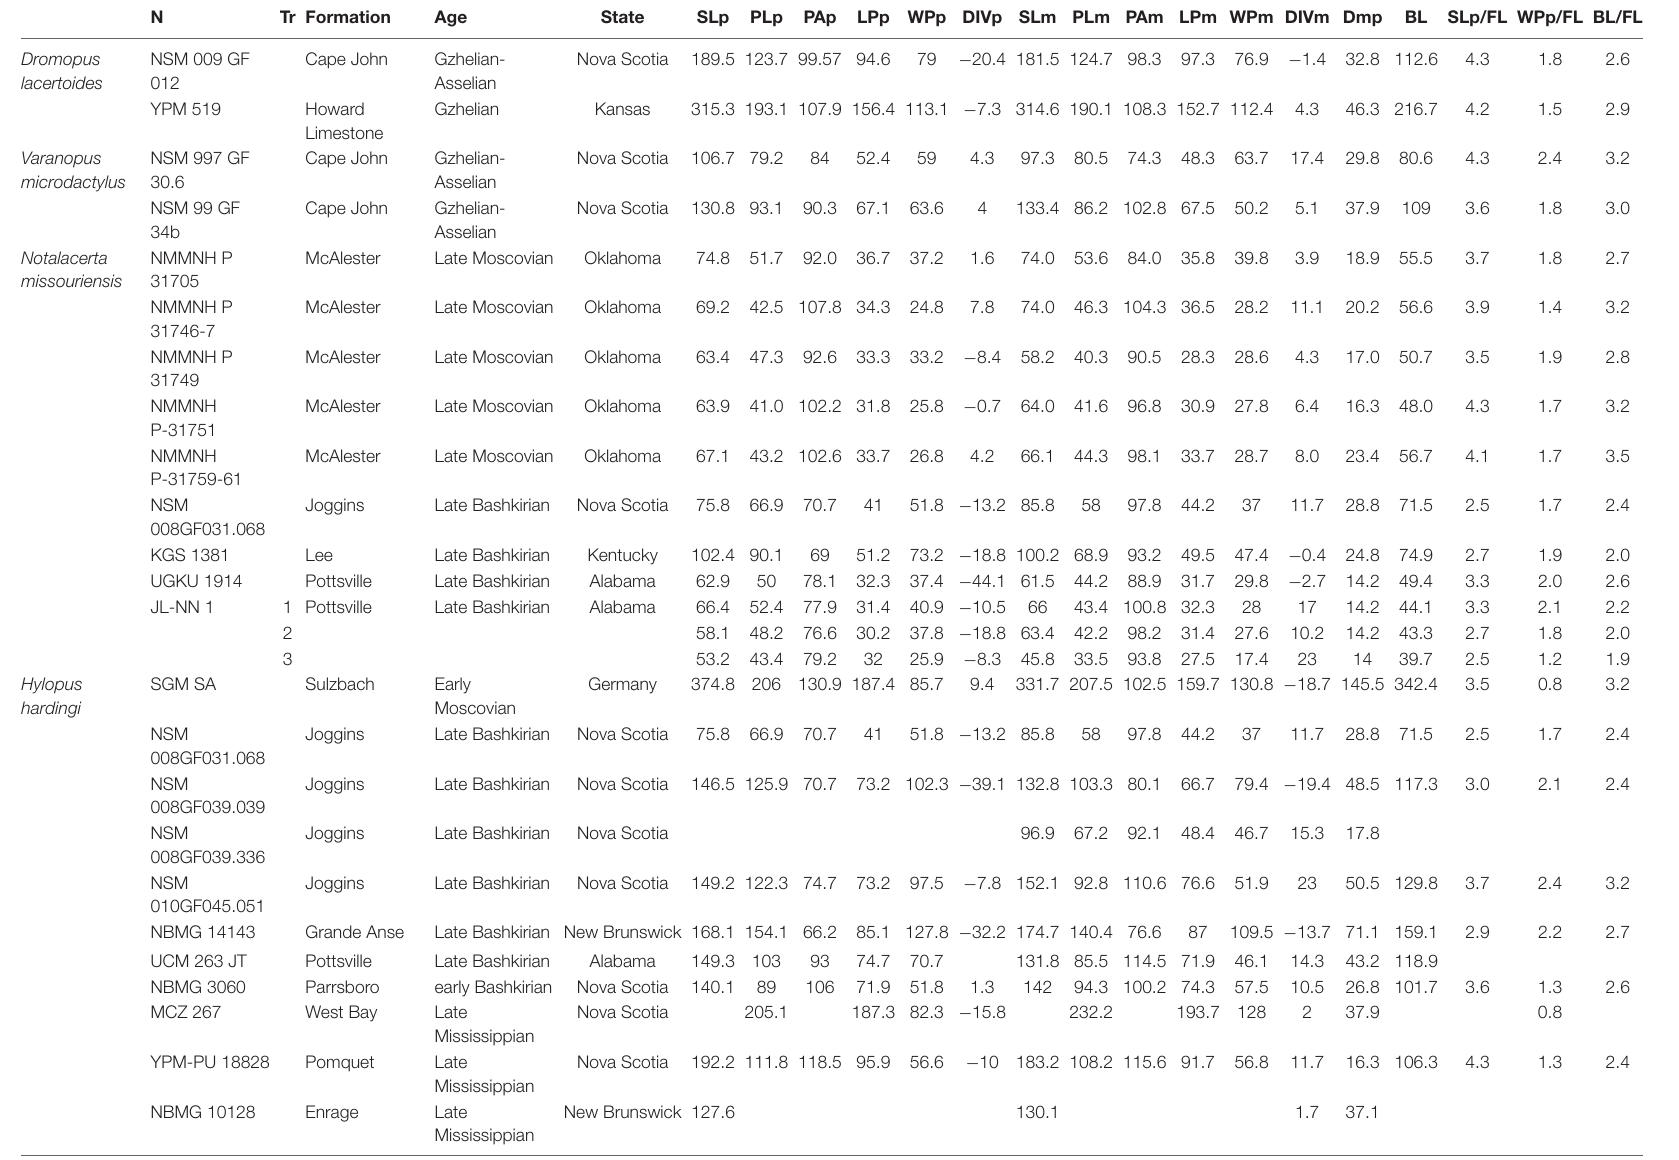
TABLE 3 | Ichnological parameters of vertebrate